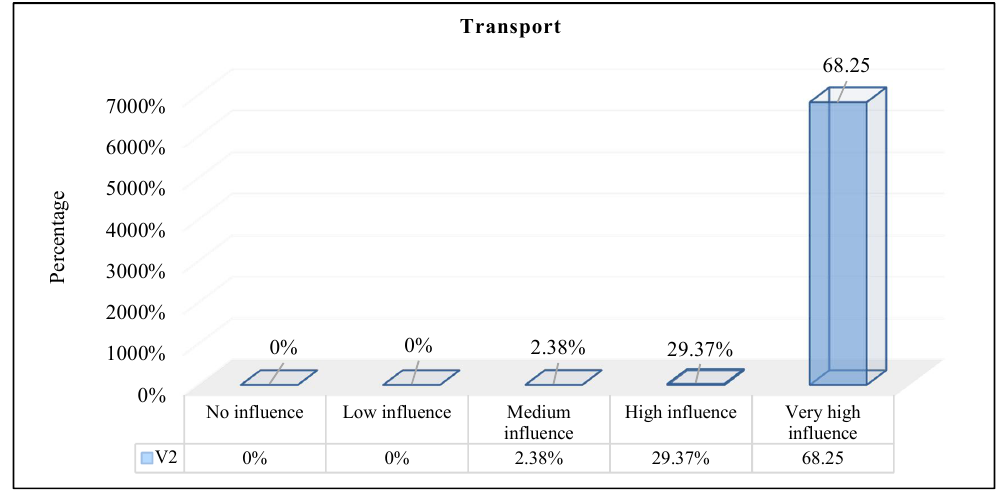
Figure 3. Histogram of respondents’ perceptions regarding transport in their manufacturing pharmaceutical